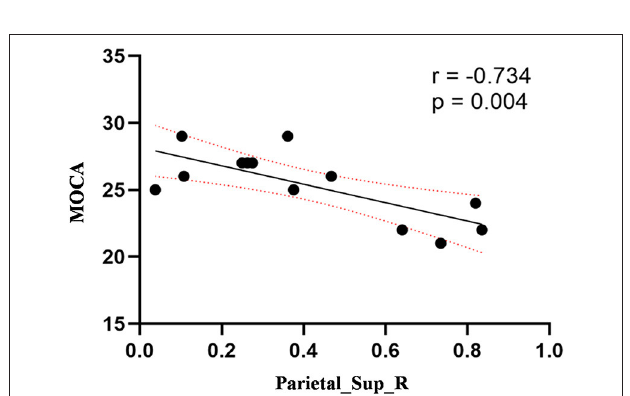
FIGURE 6 | Correlation between ReHo values of the right SPL and OC. The ReHo values of right SPL showed a negnative correlation with OC ( r = − 0.705; P =